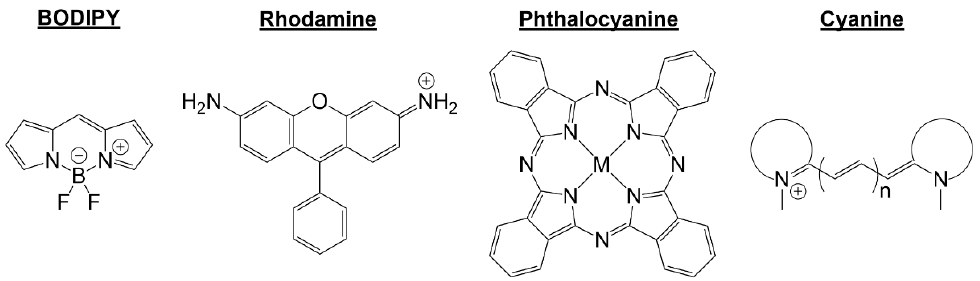
Figure 2. Fluorophore scaffolds; BODIPY, rhodamine, phthalocyanine, cyanine.